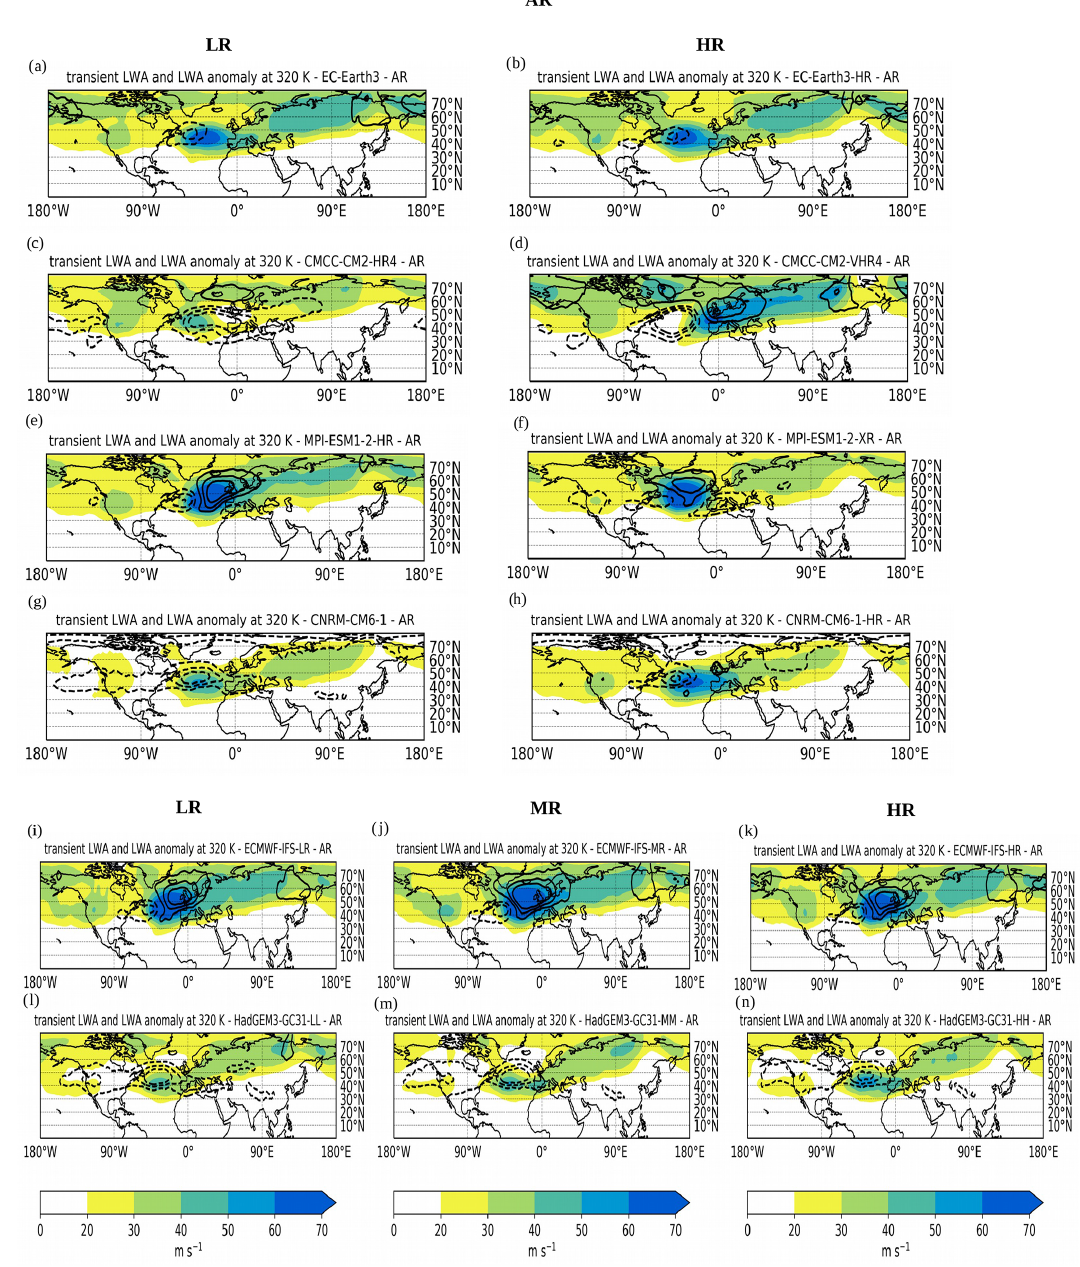
Figure 11. As in Fig. 8 but for